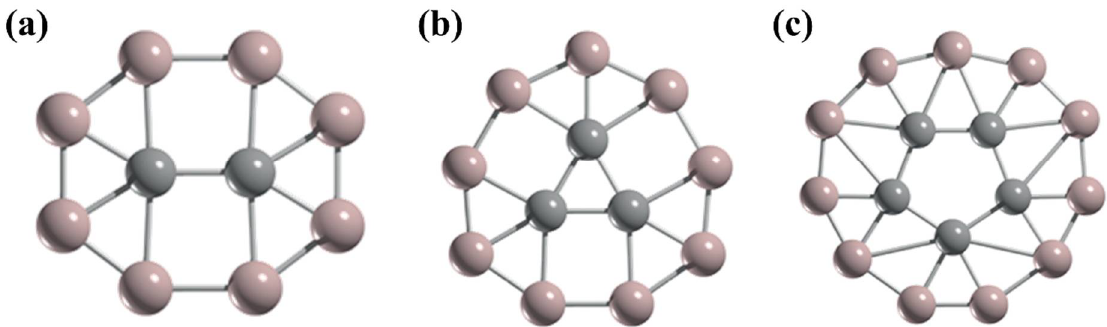
Figure 27. The boron–carbon clusters ( a ) C 2 B 8 , ( b ) C 3 B 93+ , and ( c ) C 5 B 11+ are local minimum structures that include conformationally dynamic C 2 , C 3 , and C 5 units, respectively, within boron rings.